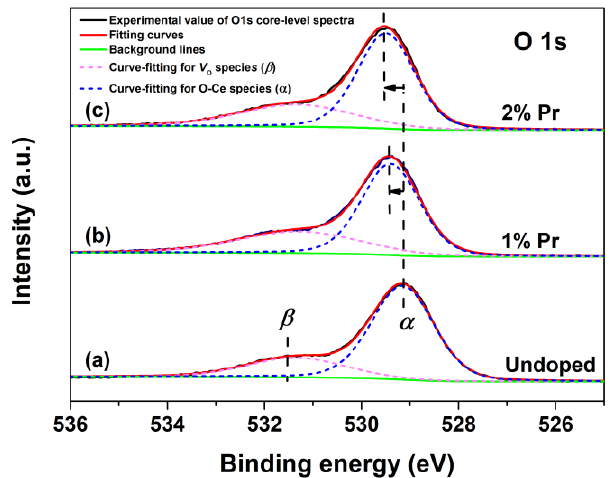
Figure 4. O1s core− level XPS spectra of ( a ) Undoped, ( b ) 1% and ( c ) 2% Pr−doped CeO 2 .